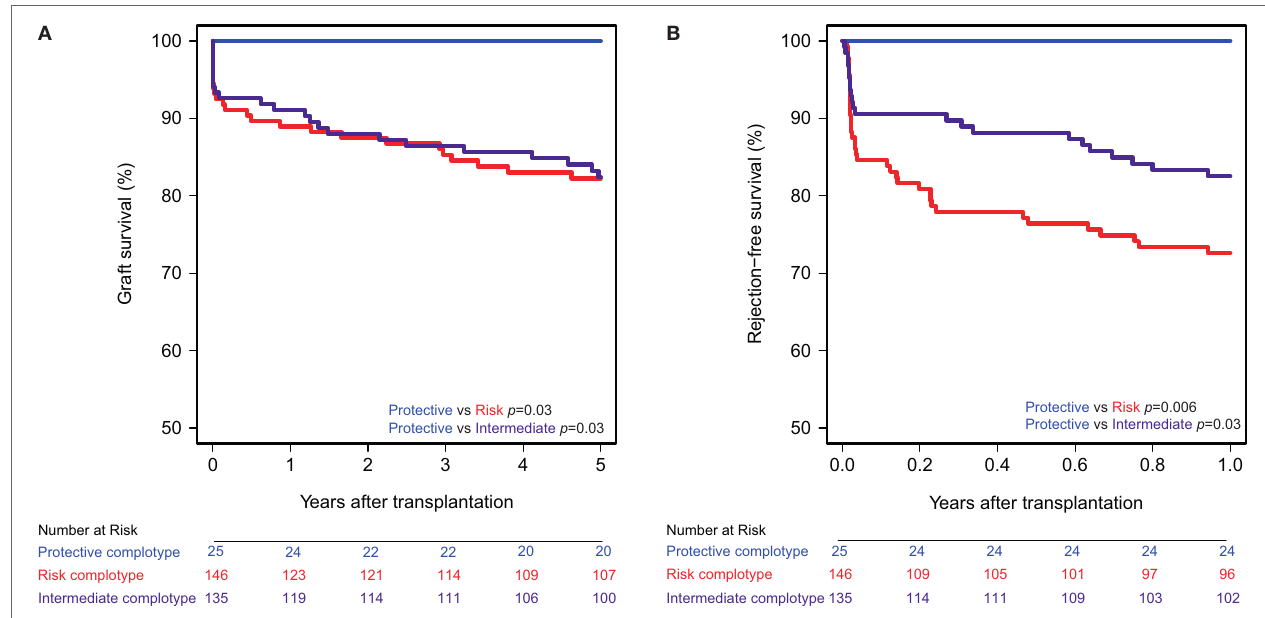
FigUre 3 | Graft and rejection-free survival according to donor complotype. Protective complotype (CD46 SNP A: A/A and CD59 SNP: A/ − ), risk complotype (CD46 SNP A: G/R and CD59 SNP: − / − ), and intermediate complotype (CD46 SNP A: G/R and CD59 SNP: A/ − or CD46 SNP A: A/A and CD59 SNP: − / − ). (a) 5-year death-censored graft survival according to donor complotype: protective vs. risk complotype ( p = 0.03) and protective vs. intermediate complotype ( p = 0.03). (B) 1-year rejection-free survival according to donor complotype: protective vs. risk complotype ( p = 0.006), protective vs. intermediate complotype ( p = 0.03), and intermediate vs. risk complotype ( p = 0.05).